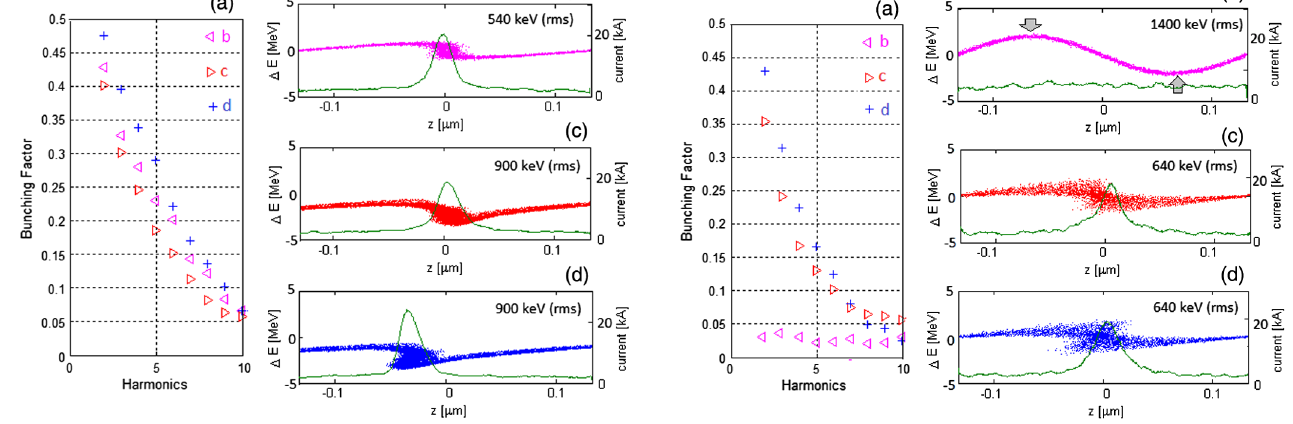
FIG. 1. Simulation of the longitudinal phase space distribution of a 266 nm wavelength seeded microbunch before (b) and after (c) the application of a CSR impedance. In (d), the microbunch has experienced an additional 10 μ m of dispersion in the first half of a radiator. The bunching factor plotted in (a) is the absolute value of the Fourier transform of the longitudinal current distribution shown in (b – d). The dispersion was 80 μ m, the beam energy was 700 MeV, the bend radius was 20 m, and the initial peak current was 5 kA. The 100 keV (rms) uncorrelated spread increases to 540 keV (rms) after seeding and increases after compression with CSR. The average energy of the microbunch is reduced.